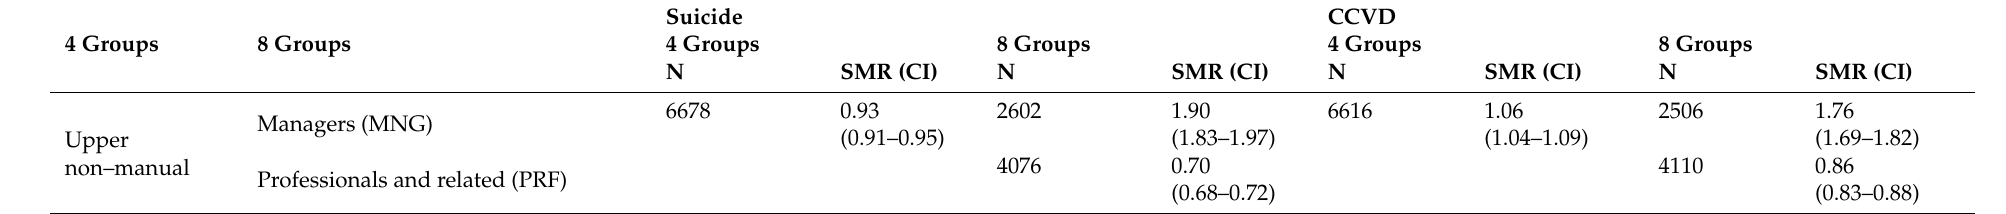
Table A2. Comparison of SMR by occupational groups in men,